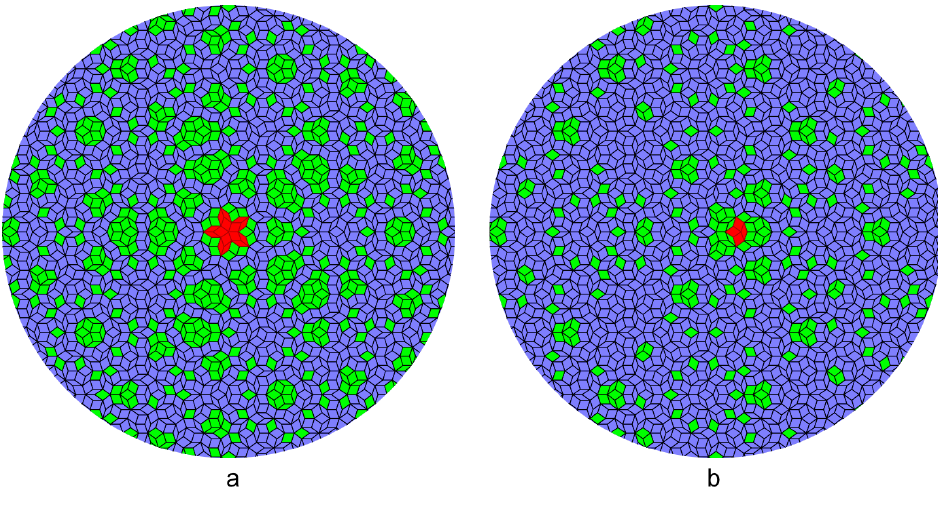
Figure 8. Results of the empire calculation for two different local vertex types in Penrose tiling, using the multigrid method. The green tiles are the forced tiles (empire) by the local vertex configuration (red), while the blue tiles are not forced.